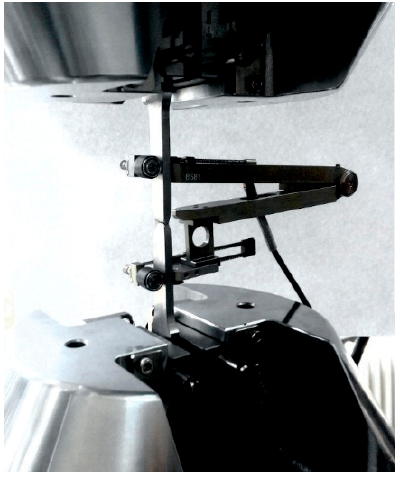
Figure 8. Mess & Feinwerktechnic GmbH MFA25 extensometer.